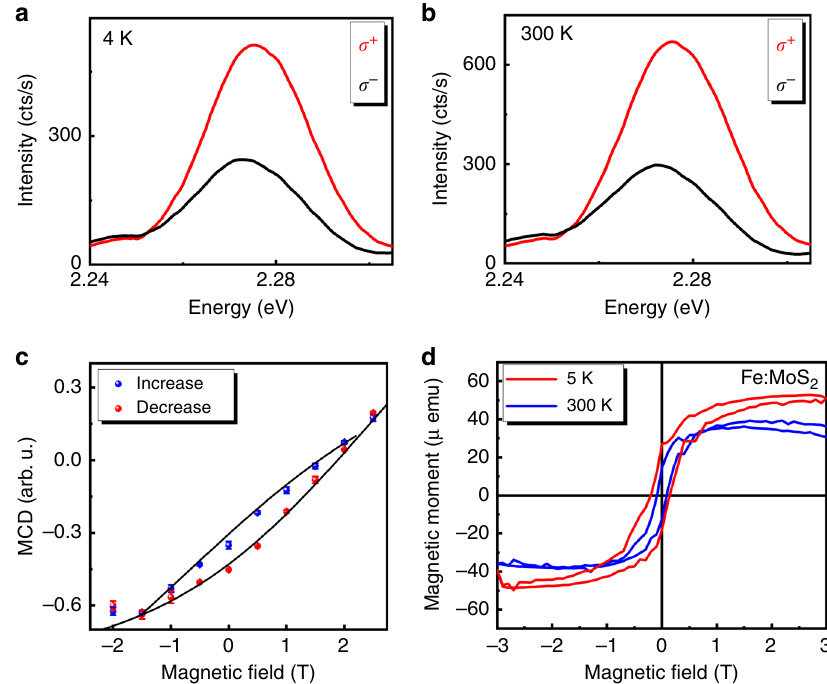
Fig. 4 Magneto-photoluminescence measurements of Fe-related emission. a , b Fe-related spontaneous emission under excitation with opposite circularly polarized light states at 4 K and 300 K. The red and black spectra correspond to excitations with σ + and σ − polarizations, respectively. c Corresponding magnetic circular dichroism (MCD) as a function of increasing (blue circles) and decreasing (red circles) magnetic fi eld, recorded at 4 K. d Magnetization data of Fe:MoS 2 monolayers at cryogenic and room temperatures, after subtracting the diamagnetic background. A pronounced hysteresis loop is observed in Fe:MoS 2 monolayers, suggesting ferromagnetism is preserved up to room temperature (300